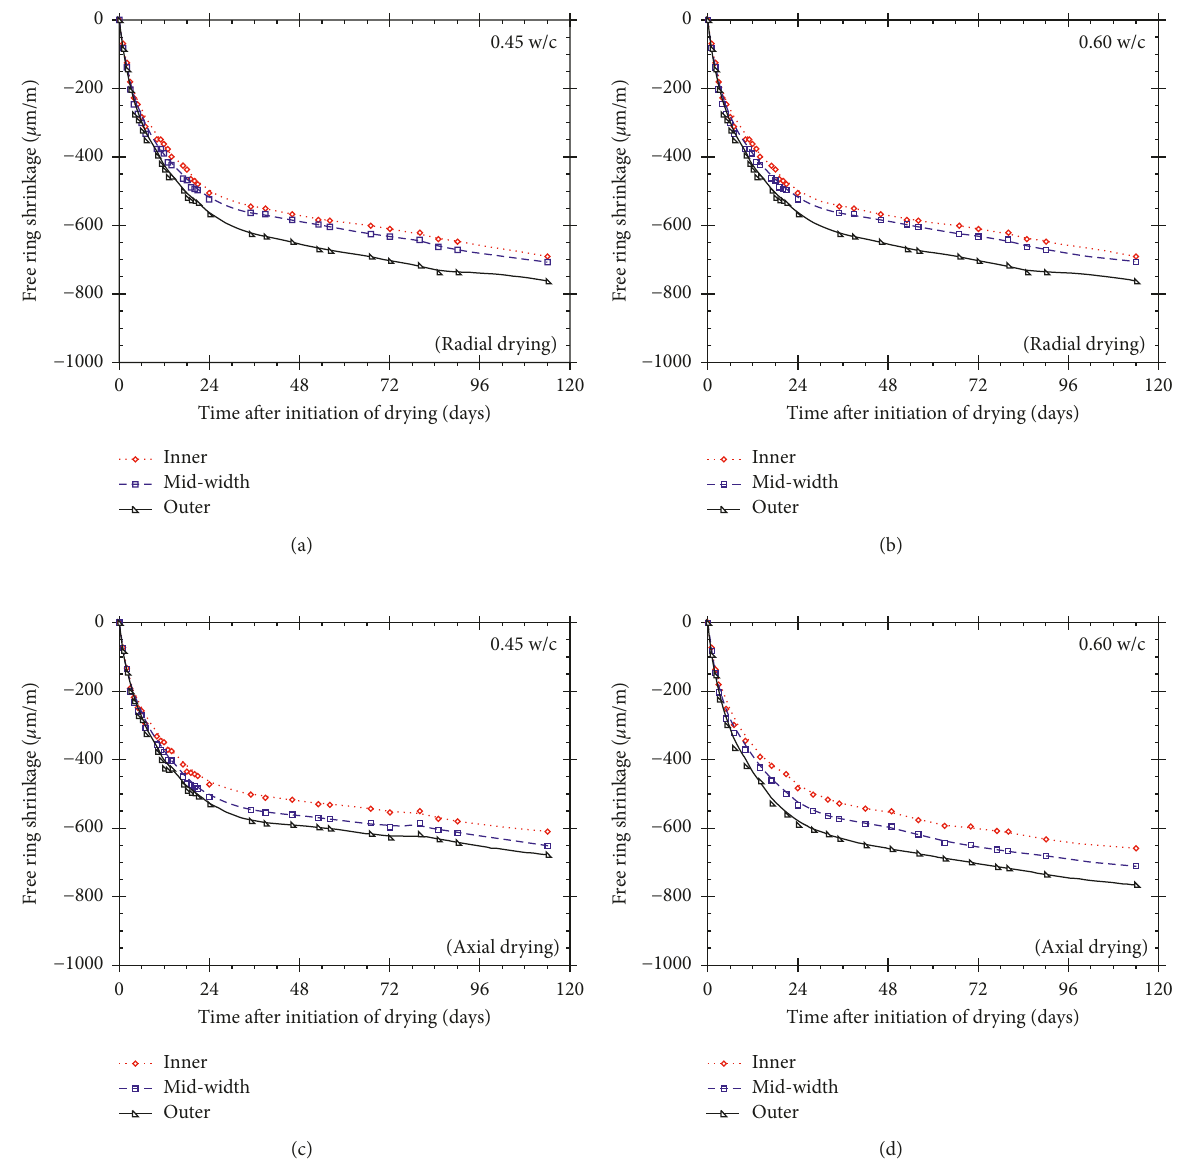
Figure 7: The influence of DEMEC gage positioning on the measured free ring shrinkage strain. (a) w/cm 0.45 radial drying specimen, (b) w/cm 0.60 radial drying specimen, (c) w/cm 0.45 axial drying specimen, (d) w/cm 0.60 axial drying